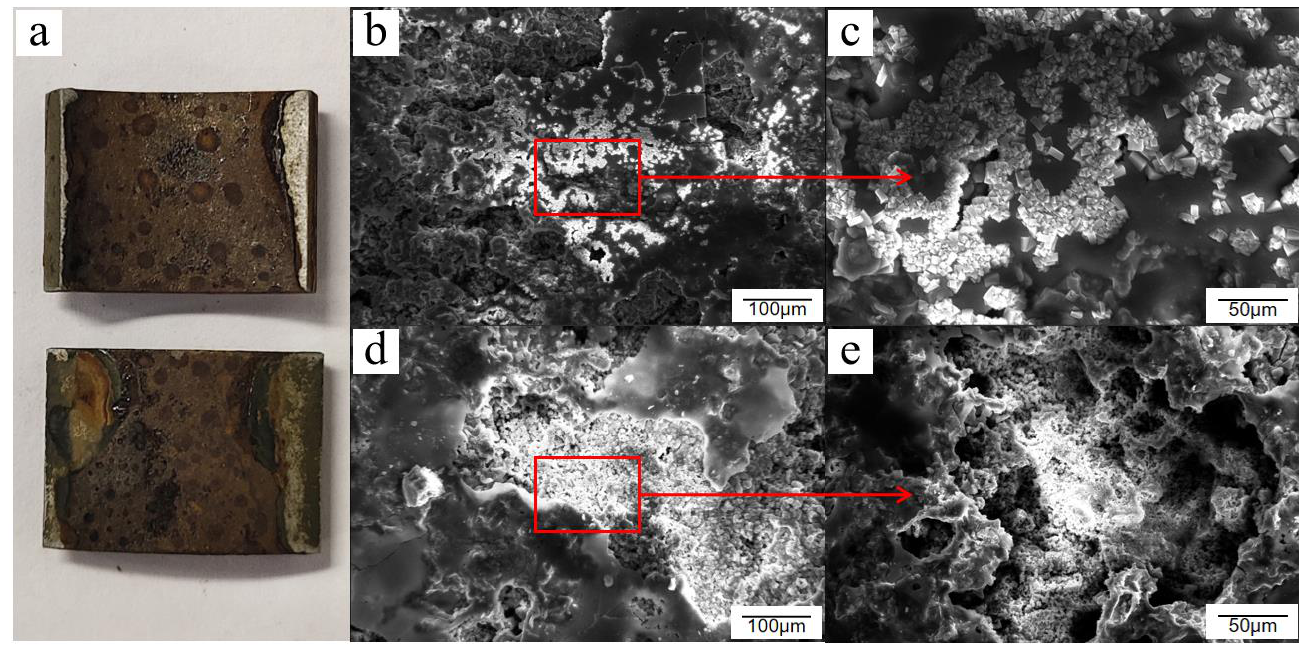
Figure 5. Macroscopic and microscopic morphology of Q235 low-carbon steel after 4 days of expo- sure in the cyclic salt spray accelerated corrosion test: ( a ) macroscopic appearance, ( b ) rupture area, ( c ) precipitation of crystals, ( d ) weak area, and ( e ) deep rupture. ( c ) precipitation of crystals, ( d ) weak area, and ( e ) deep